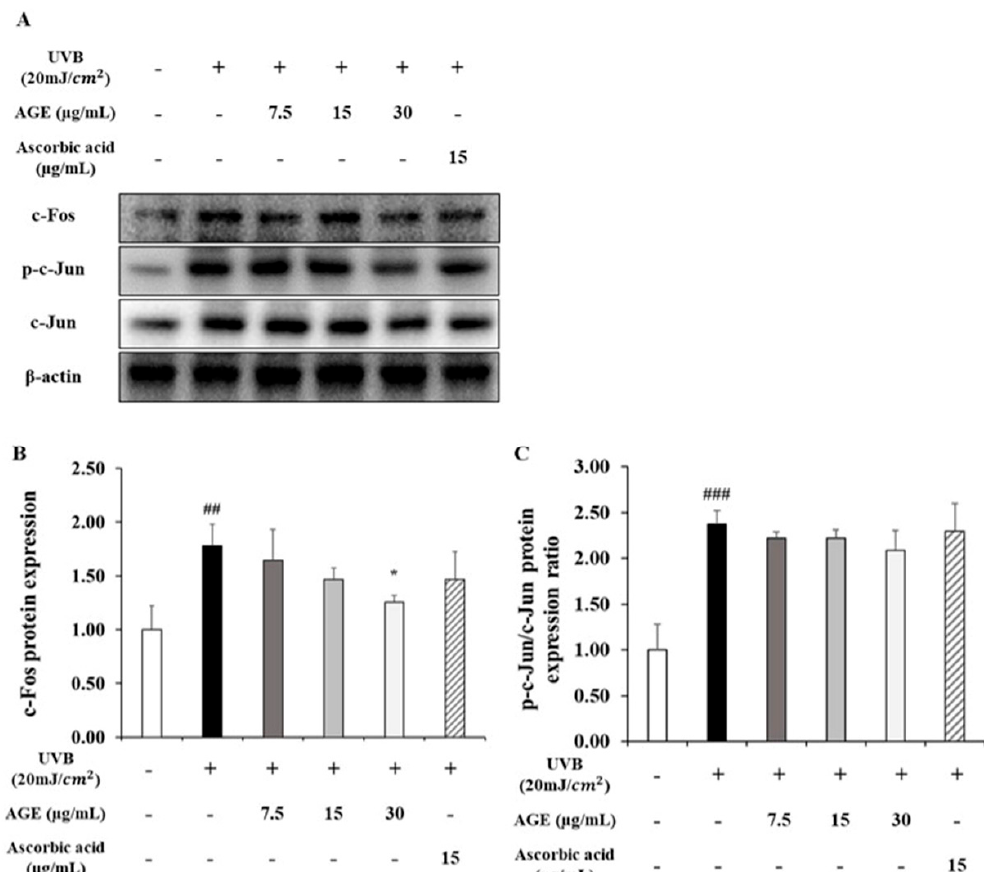
Figure 5. Effects of AGE on the expression of AP-1 in UVB-irradiated HDFs. HDFs were irradiated with UVB (20 mJ/cm 2 ), followed by treatment with 7.5, 15, and 30 µg/mL of AGE. After 24 h of incubation, protein extraction was performed. Protein expressions of c-fos ( B ), c-jun, and p-c-jun ( C ) were determined by Western blot ( A ). All data were expressed as the mean ± SD of at least three independent experiments. ## p < 0.01 and ### p < 0.001 versus untreated cells, * p < 0.05 versus UVB-irradiated cells.